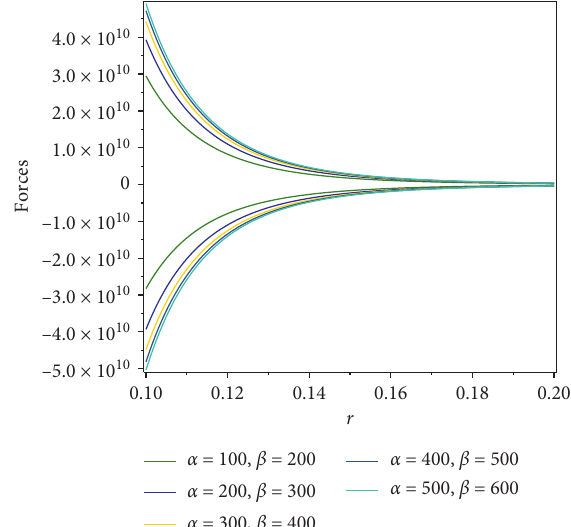
Figure 8: Behavior of hydrostatic and gravitational forces ( F